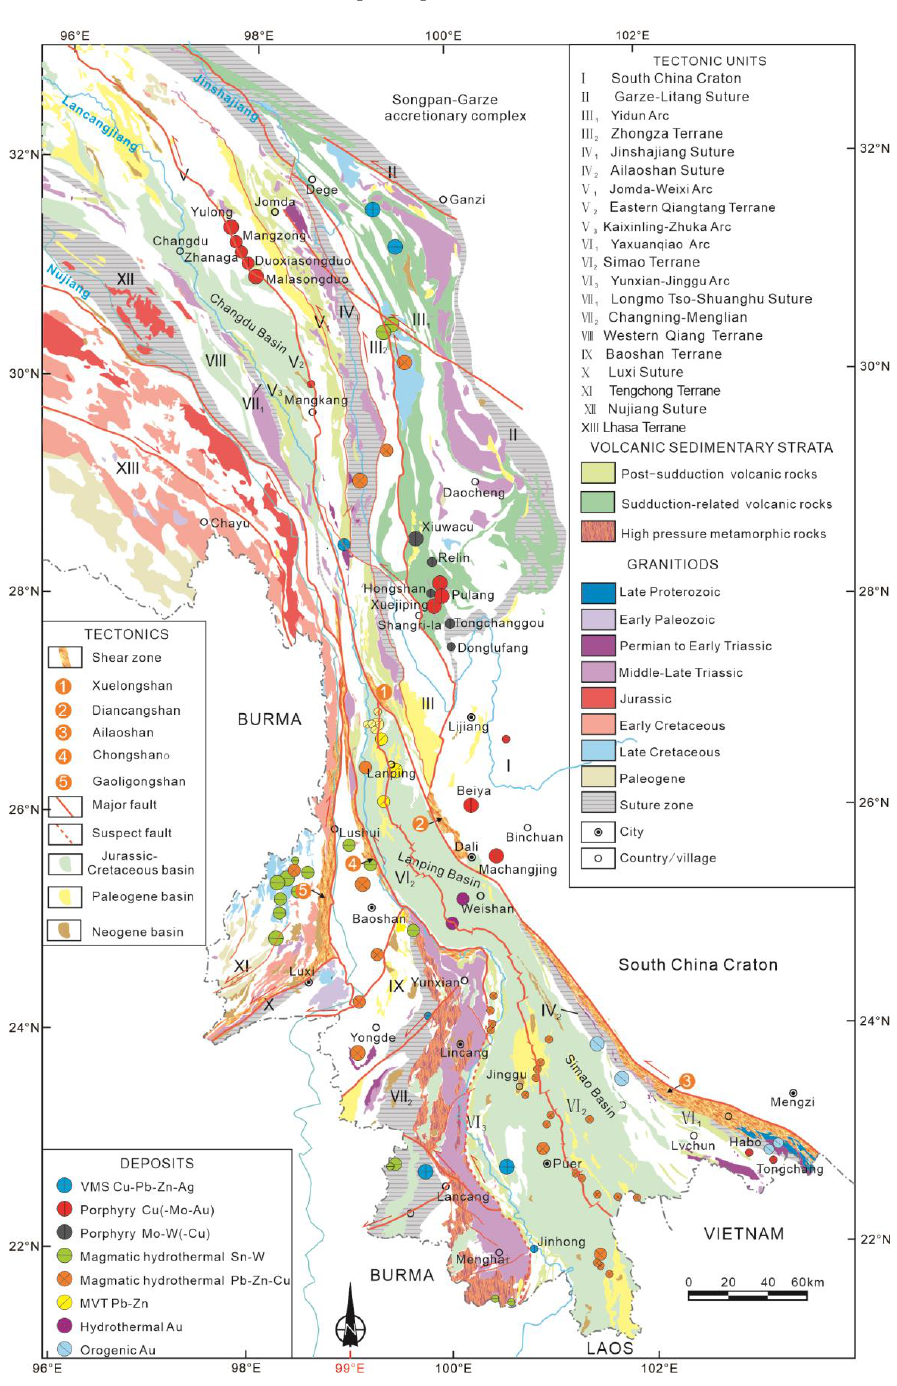
Figure 2. Geological map of the Sanjiang Tethyan Orogen showing the distribution of Early Paleozoic to Cenozoic igneous rocks and major ore deposit. Adapted with permission from Ref. [17]. Copyright 2016. ELSEVIER .